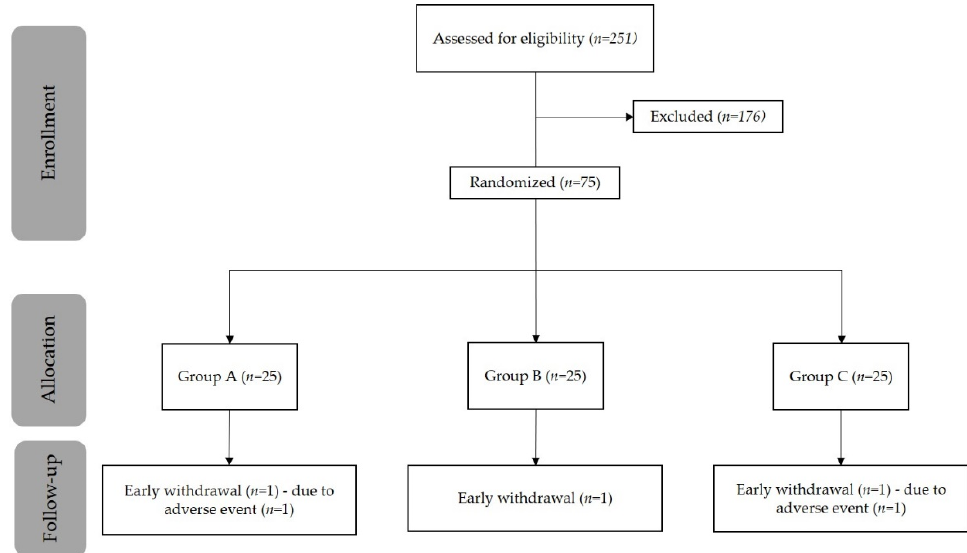
Figure 1. Patient disposition.